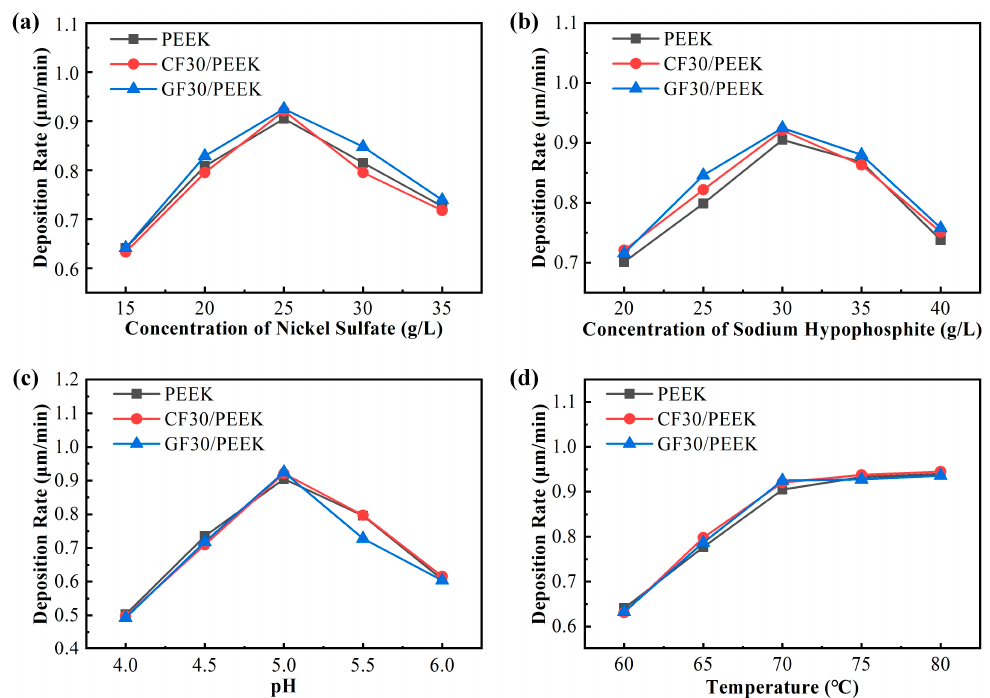
Figure 11. Experimental results of parameter optimization: ( a ) Effect of concentration of nickel sulfate; ( b ) Effect of concentration of sodium hypophosphite; ( c ) Effect of pH; ( d ) Effect of temperature.